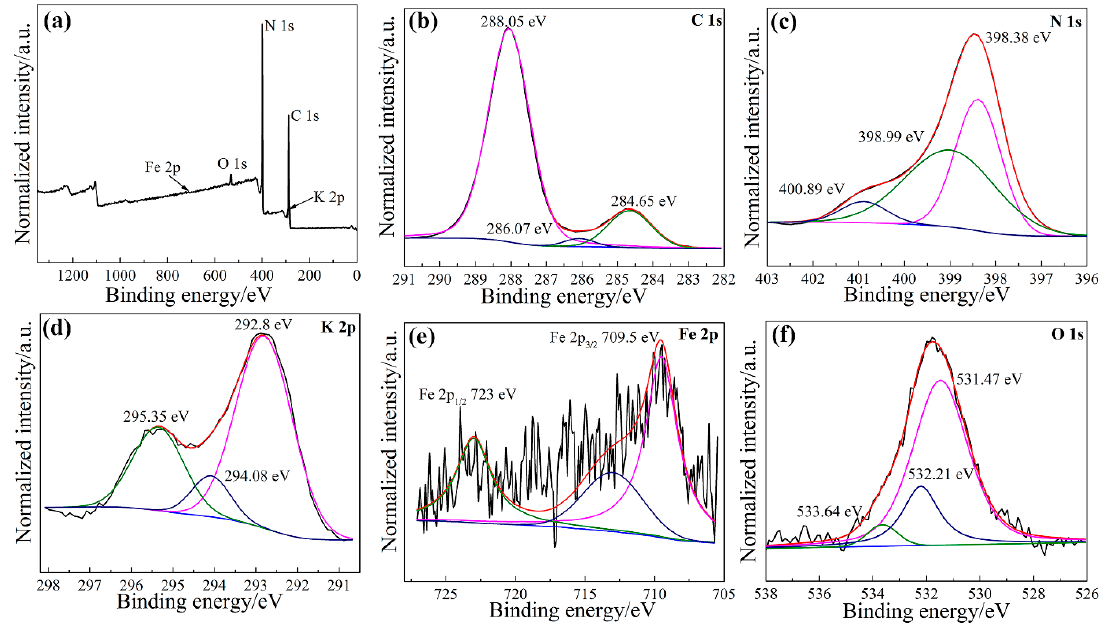
Figure 3. X-ray photoelectron spectra (XPS) spectra of AKCN-0.010Fe: ( a ) survey, ( b ) C 1s, ( c ) N 1s, ( d ) K 2p, ( e ) Fe 2p, and ( f ) O 1s.